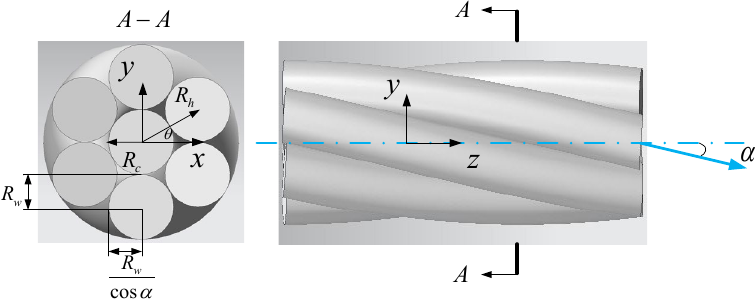
Figure 1. Geometry of a typical simple strand: cross-section view ( left ); side view ( right ). The centerline of the outer wire is a first-order helical curve characterized by helical radius R h and pitch length p . The pitch length is defined as the distance between two nodes situated on the helical wire whose corresponding angular phases differ by 2 π along the longitudinal axis of the strand. The parametrical equation of the helical curve is expressed as: